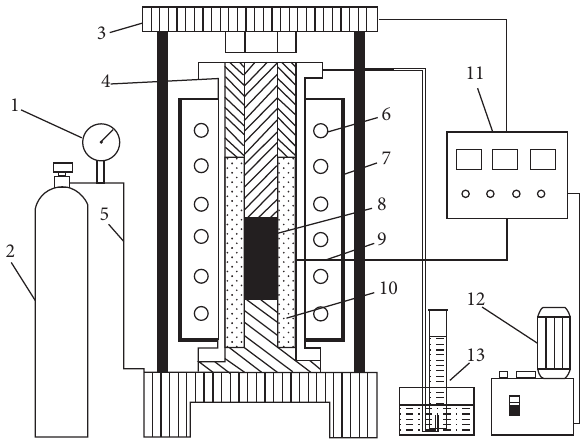
Figure 3: Schematic diagram of high-temperature triaxial